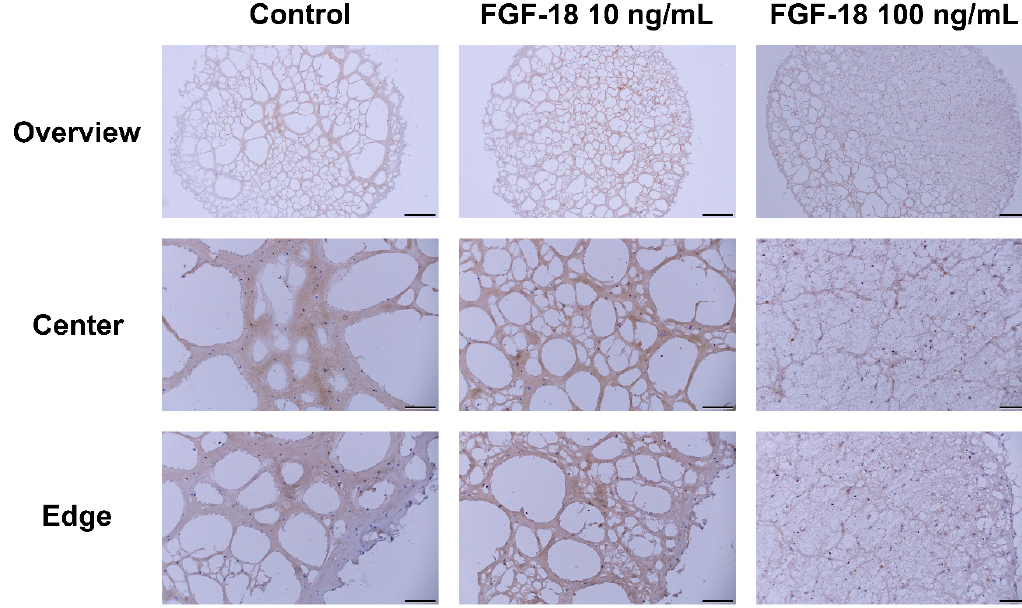
Figure 8. Collagen type II immunohistochemistry staining of human (mildly degenerated) nucleus pulposus cells encapsulated in FBG-HA hydrogel and stimulated with 0, 10, or 100 ng/mL FGF-18 after 14 days of culture. Scale bar: overview—500 µm, center and edge—100 µm.